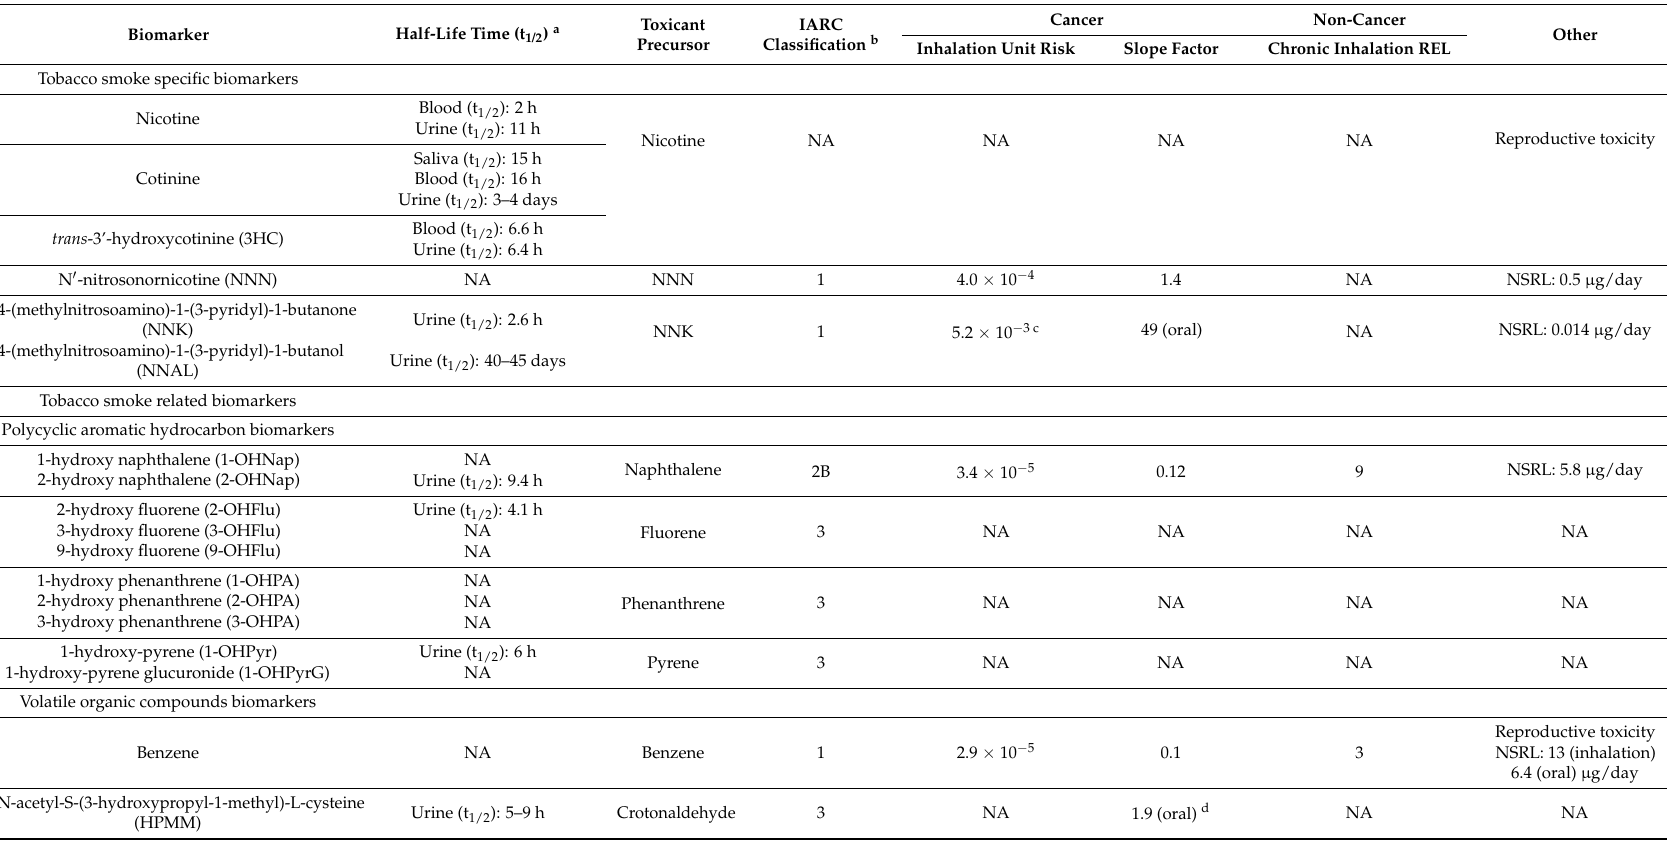
Table 1. Biomarkers of tobacco smoke exposure studied in the reviewed papers, their half-life time, precursor toxicant and main toxicological characteristics including: The International Agency for Research on Cancer (IARC) classification; cancer inhalation unit risk, expressed in ( µ g/m 3 ) − 1 ; inhalation and oral cancer slope factors, in (mg/kg-day) − 1 ; non-cancer chronic inhalation reference exposure level (REL), in µ g/m 3 ; and other relevant toxicological information. Risk values are from the Office of Environmental Health Hazard Assessment at the California Environmental Protection Agency (OEHHA-CalEPA) Chemical Database [29]. Different sources of information are